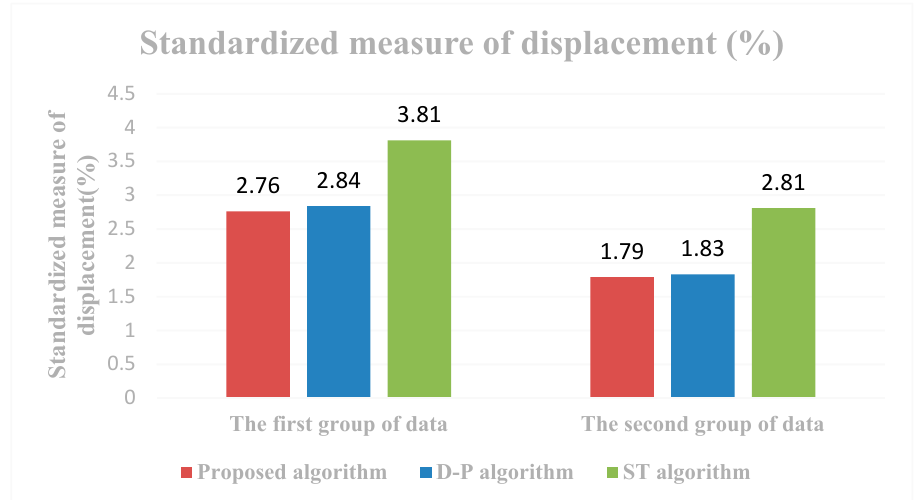
Figure 8. The standardized measure of displacement results (%).